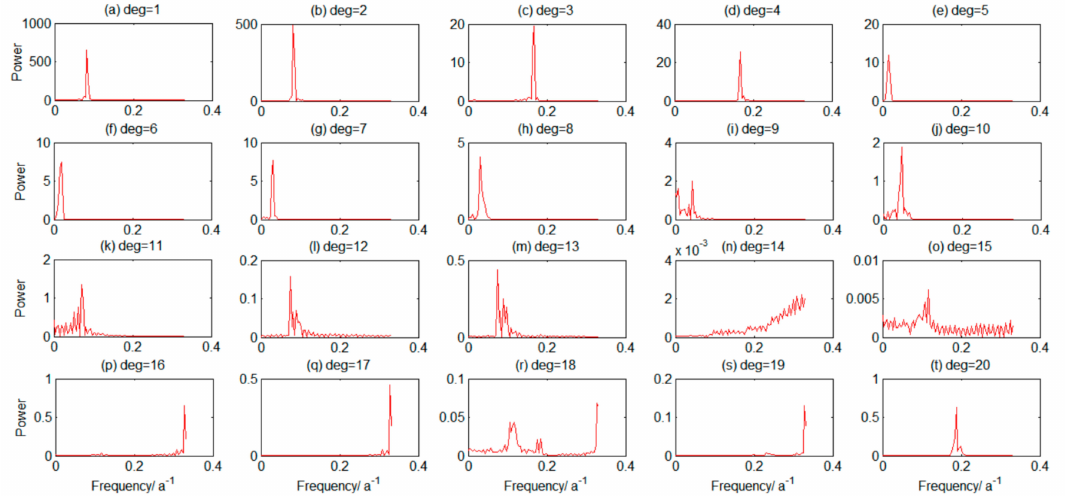
Figure 4. Fourier transform (FFT) period detection results of TWSA in Southwest